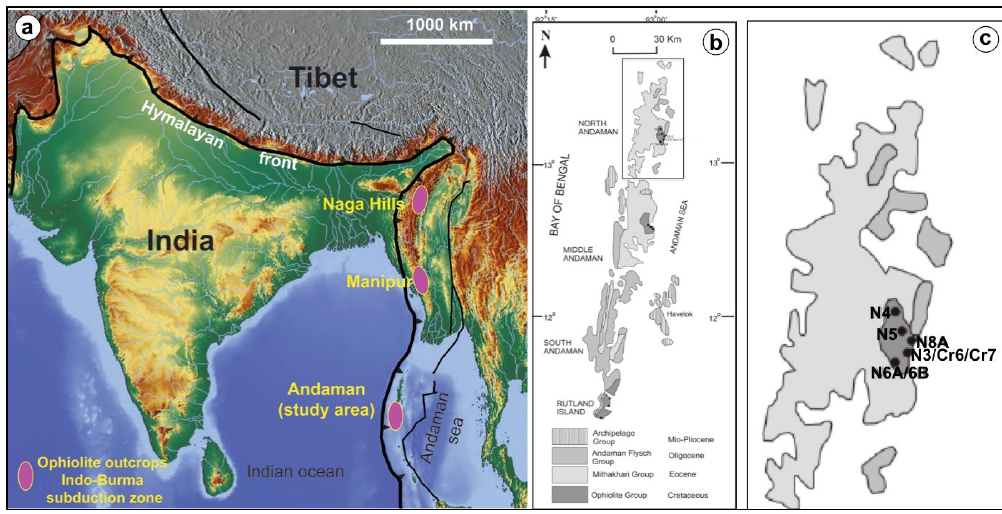
Figure 1. ( a ) Location of the Andaman and Nicobar Islands within the geological framework of the Indo-Burma-Sumatra subduction zone (Plate boundaries after [46]); ( b , c ) Schematic maps of North Andaman showing the location of the samples employed in this study at the north part of the Island.